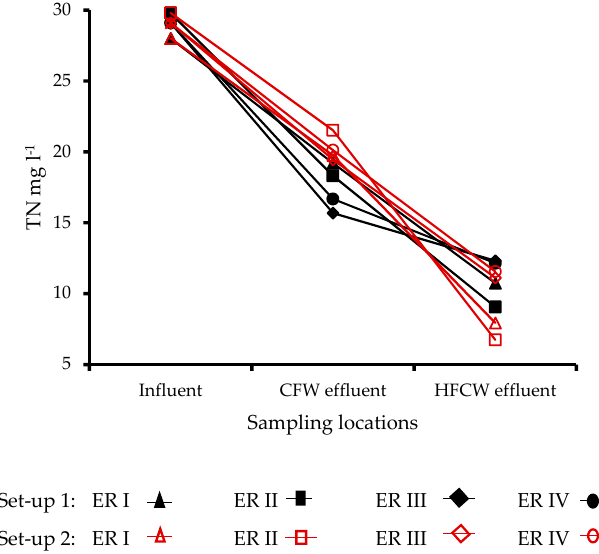
Figure 5. Total nitrogen concentration during different experimental runs in the first and second setups.